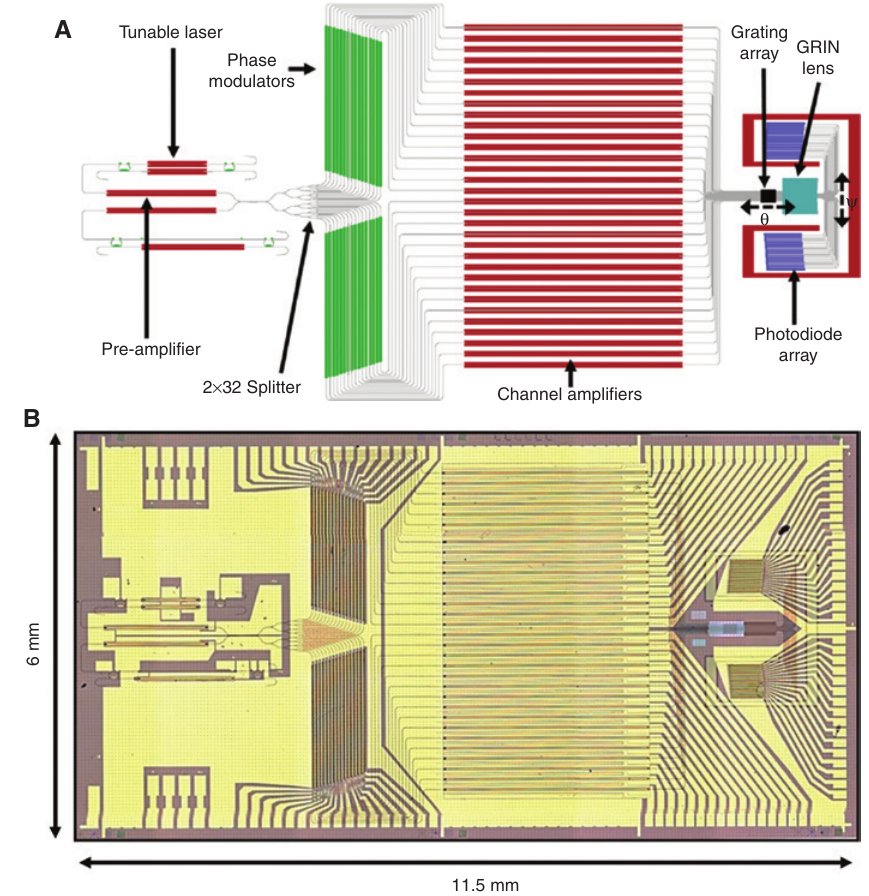
Figure 12: (A) Mask layout of a fully integrated hybrid silicon OPA, including tunable laser sources, optical pre-amplifiers (SOA), phase tuning and grating emitters in 32 channels. A GRIN lens images the remaining beam power into a photodetector array, mimicking the far field. (B) Microscope picture of the fully integrated beam-steering hybrid silicon PIC. A total of 164 photonic components were integrated. Reprinted by permission of The Optical Society [37].